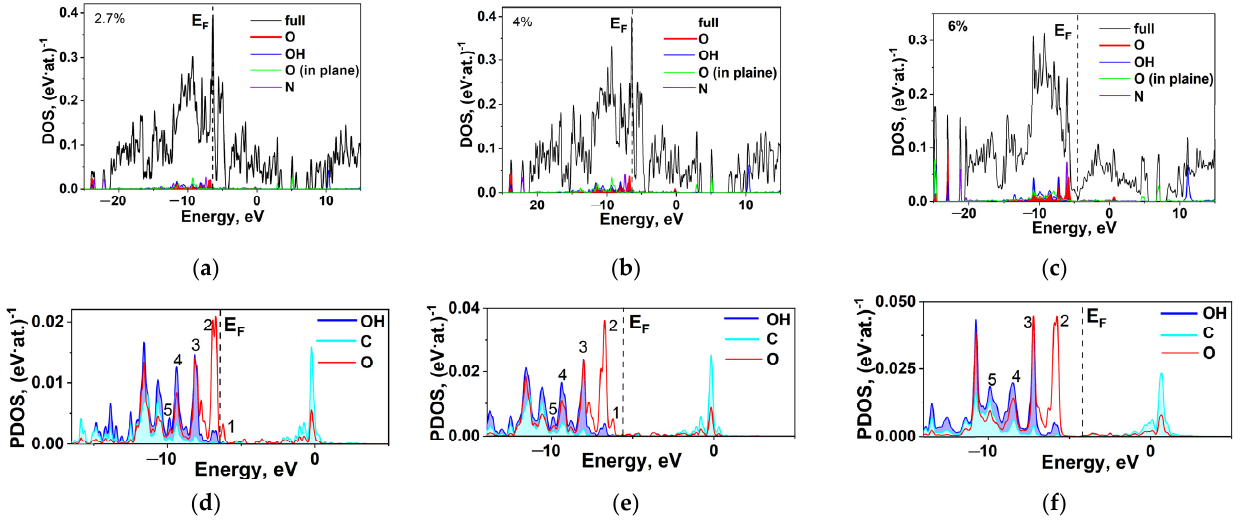
Figure 3. Electronic DOS and PDOS in functionalized N-MWCNTs with ( a , d ) S1; ( b , e ) S2; and ( c , f ) S3 structure.